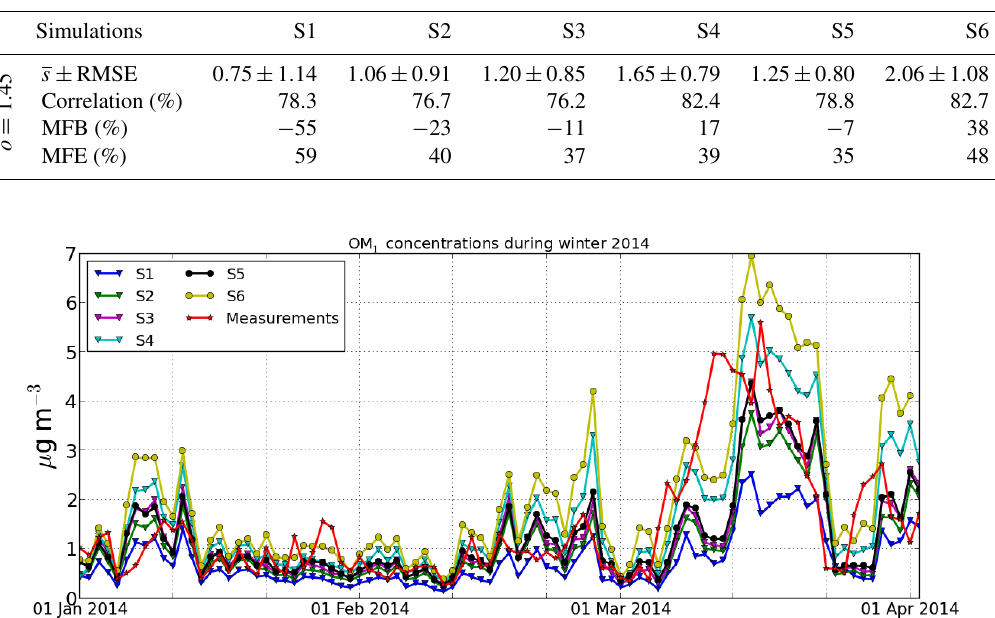
Table 6. Statistics of model to measurements comparisons for daily OM 1 concentrations during the winter campaign of 2014 at Ersa. o refers to the observed mean. Other statistical indicators are defined in Table A1 of AppendixA.